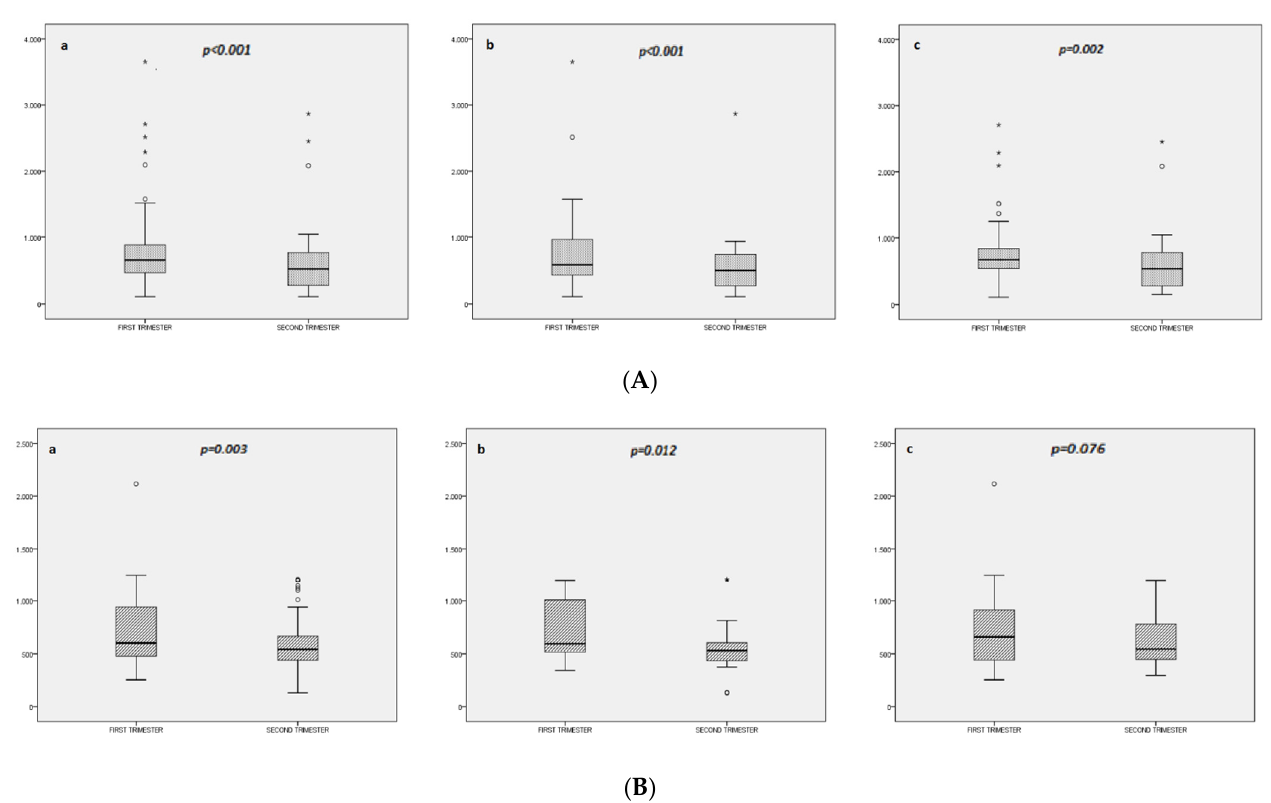
Figure 1. ( A ). Box plots of humanin levels in the first and second trimesters in the total cohort ( a ) and restricted to women with gestational diabetes mellitus (GDM) ( b ) and controls (non-GDM) ( c ). ( B ). Box plots of MOTSc levels in the first and second trimesters in the total cohort ( a ) and restricted to women with gestational diabetes mellitus (GDM) ( b ) and controls (non-GDM) ( c ). The box plots represent lines, boxes represent the median and interquartile range, and whiskers calculate outlier data. The Wilcoxon signed-rank test was used for the paired-samples comparisons between trimesters. * and ◦ represent outliers